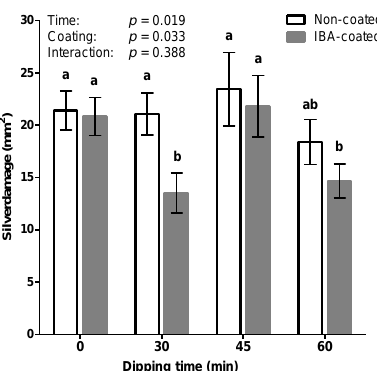
Figure 2. Effect of indole-3-butyric acid (IBA) coating and water dipping on chrysanthemum susceptibility against thrips. Basal cut ends (cv. Baltica), in the presence or absence of the powder formulated rooting hormone IBA, were dipped in water at various durations. Two weeks post treatment, cuttings were infested with 20 adult thrips for a period of one week. Cumulative silver damage data are presented as mean ± SEM ( n = 10). Different letters denote significant differences among groups as determined by generalized linear model (GLM) followed by Fisher’s least significance difference (LSD) test ( p < 0.05). The overall effects of dipping time, auxin coating and their interaction are indicated in the graph.